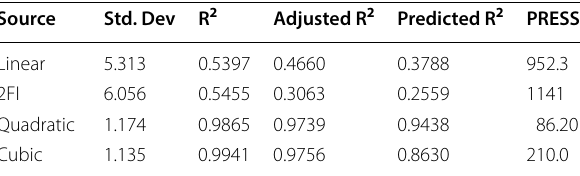
Table 4 The results of Statistics Model